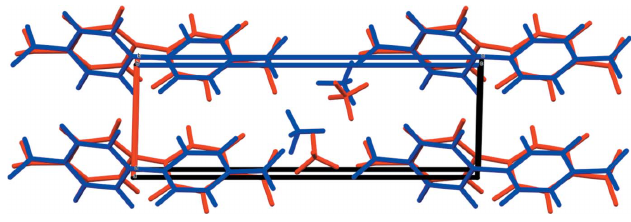
Figure 7 Comparison of the Rietveld-refined (red) and VASP -optimized (blue) structures of (NH 4 ) 2 (BPDC). The r.m.s. Cartesian displacement is 0.384 A˚ . Image generated using Mercury (Macrae et al. , 2020).